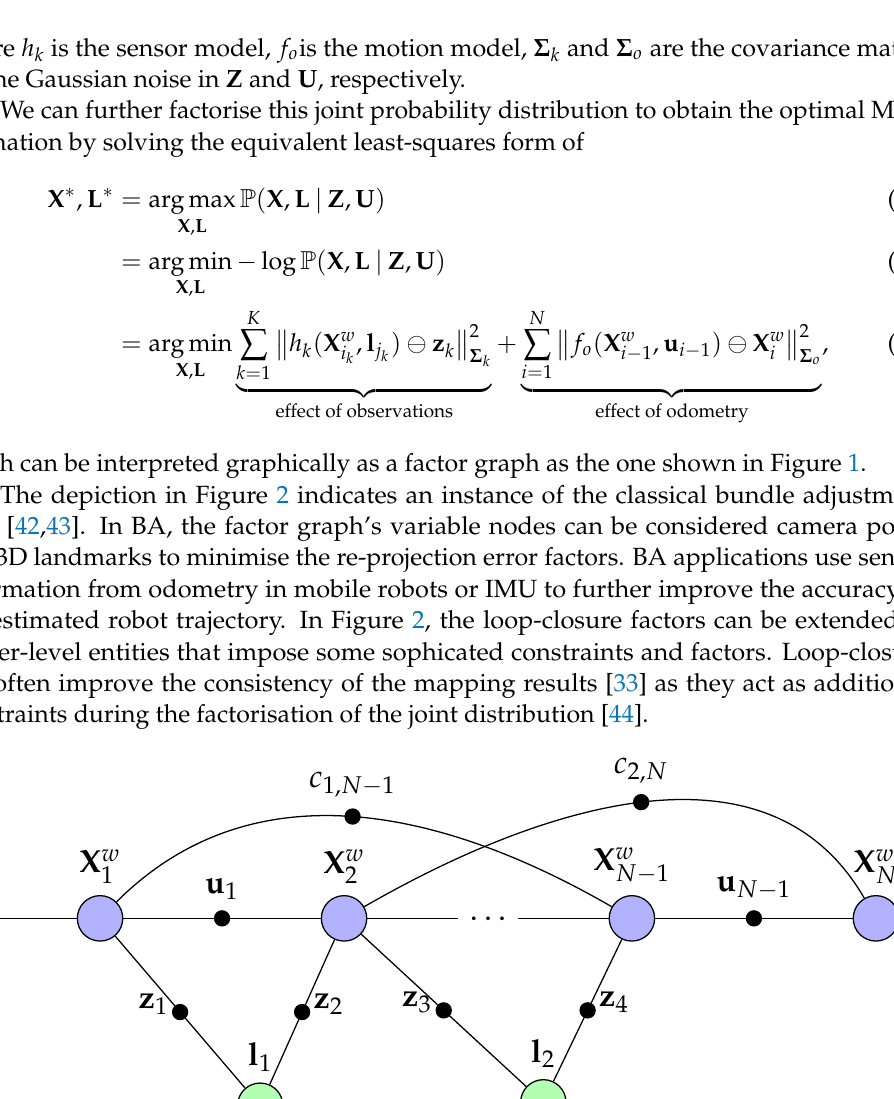
i where i 1 , i 2 are the index where i , i 2 are the index 1 , i 2 1 i 1 , i 2 1 between the camera pose between the camera pose − 1, N 1 −